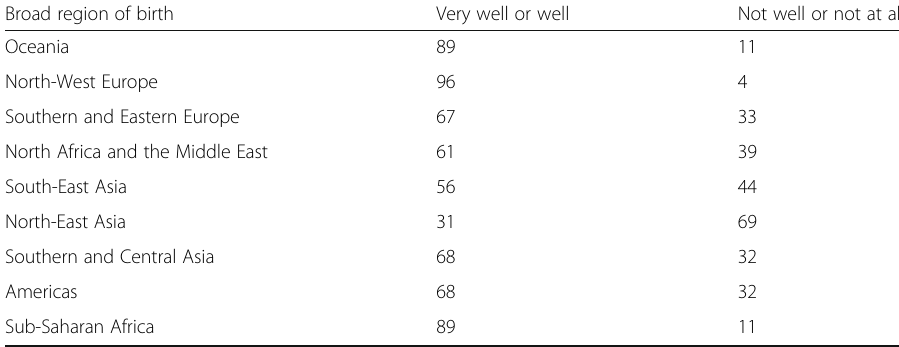
Table 1 Percentage of people aged 65+ by spoken English language proficiency, 2016 Broad region of